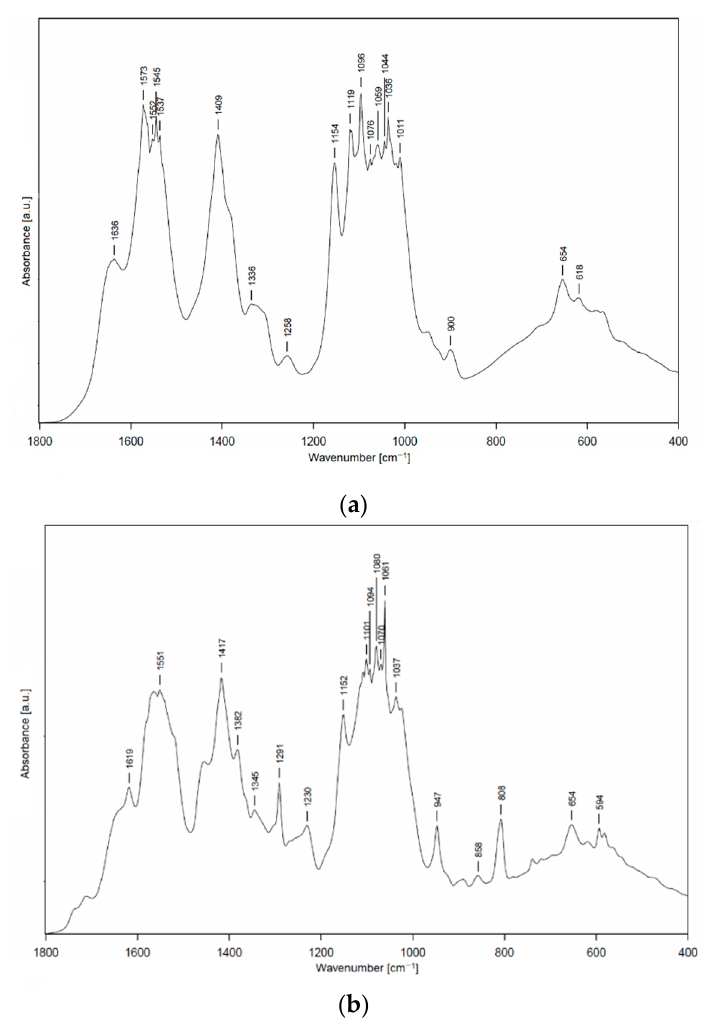
Figure 1. Fourier-transform infrared (FTIR) spectra of the chitosan film ( a ) and the chitosan film modified with 2 wt.% TEO ( b ) in the interval 1800–400 cm − 1 .